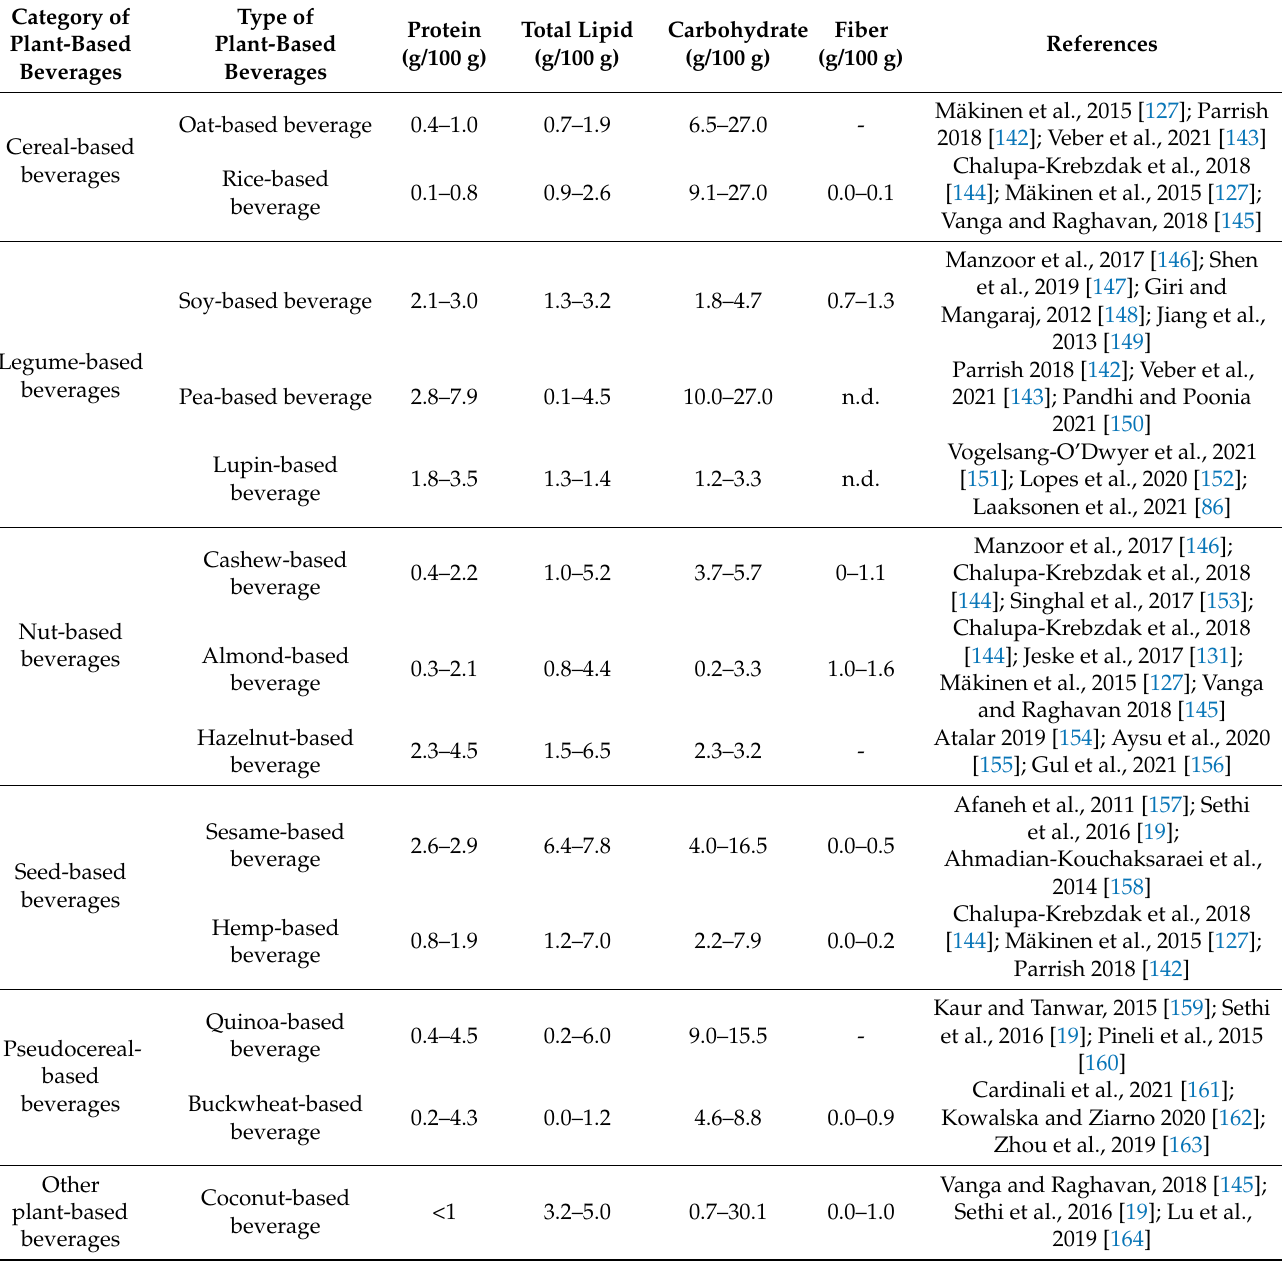
Table 5. The nutritional value of selected plant-based